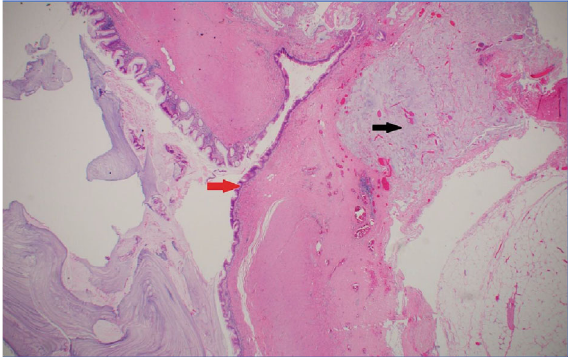
Figure 5: Low-power view of the lesion, H and E × 10. Red arrow highlights the dysplastic mucosa. Note the mucin in the wall (black arrow).